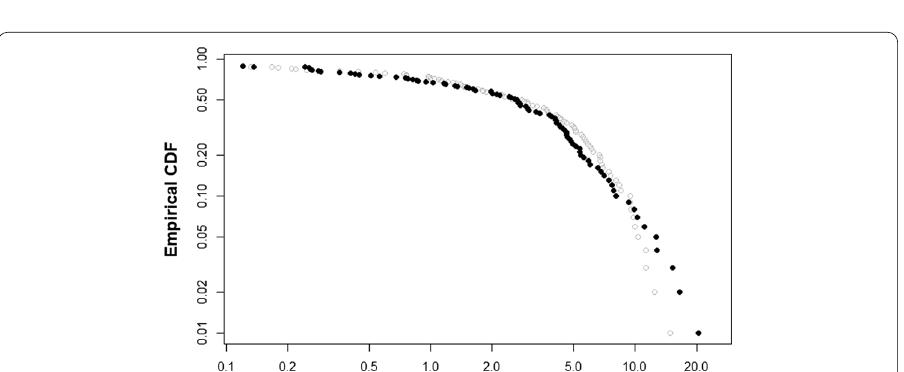
Fig. 2 Spillover densities of VARs with and without factors. Notes: This figure shows the spillover densities of the models without factors (as a dashed grey line) and with factors (black